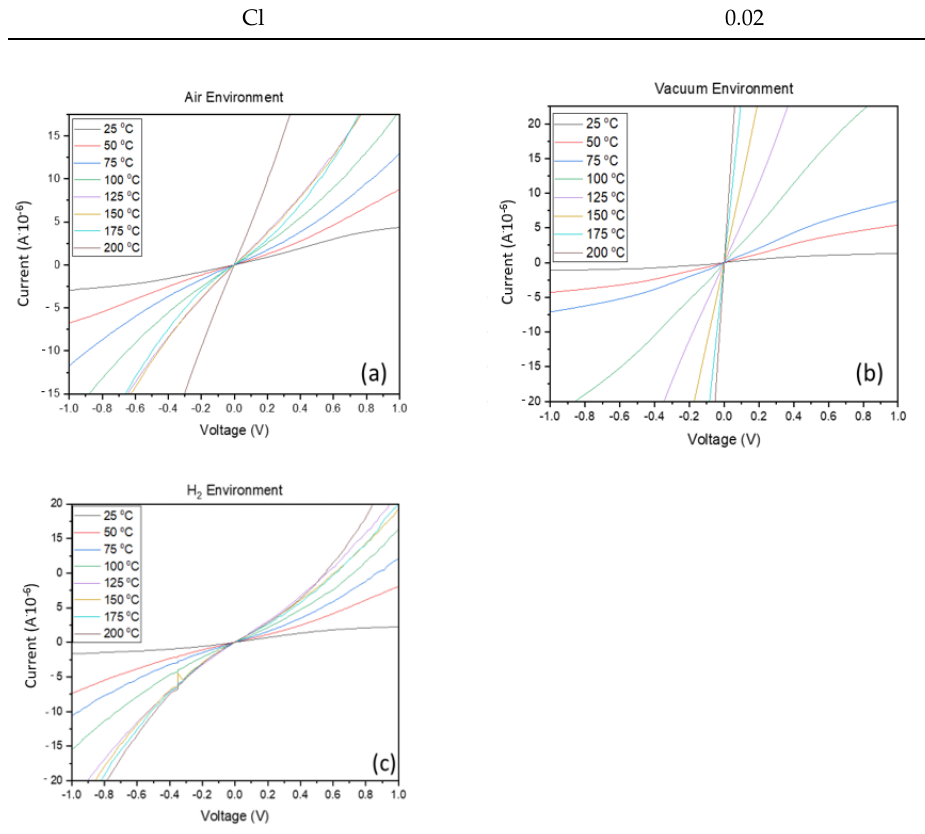
Figure 12. The I–V characteristics of SnO 2 in ( a ) dry air, ( b ) a vacuum and ( c ) a hydrogen environ-